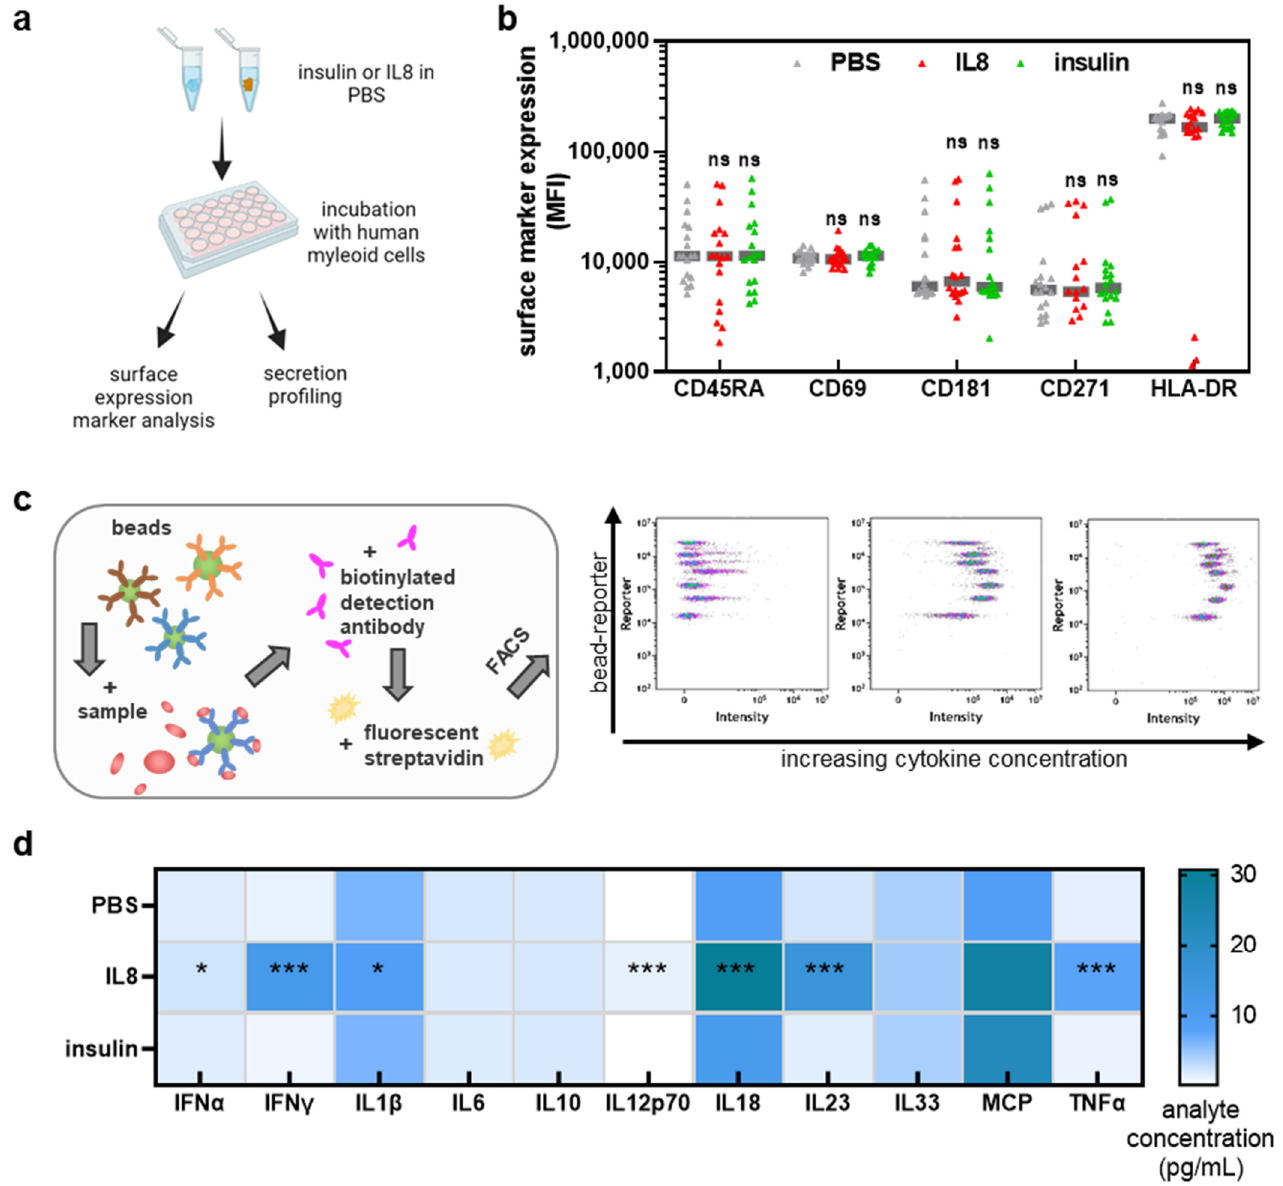
Figure 1. IL8 but not insulin triggers the secretion of pro ‐ inflammatory cytokines in THP ‐ 1. ( a ) Workflow of the experimental procedure; ( b ) surface marker expression on IL8 or insulin ‐ spiked THP ‐ 1 cells reveals no differences compared to unstimulated cells; ( c ) principle of bead ‐ based multiplex assay; ( d ) absolute chemokine and cytokine levels of THP ‐ 1 cells exposed to IL8 or insulin. Data are the mean of at least three independent experiments. Statistical analysis was performed using two ‐ way analysis of variances; for ANOVA: F = 2.8 ( b )/33.2 ( d ), df = 2 ( b )/2 ( d ). (* = p < 0.05; *** p < 0.001).